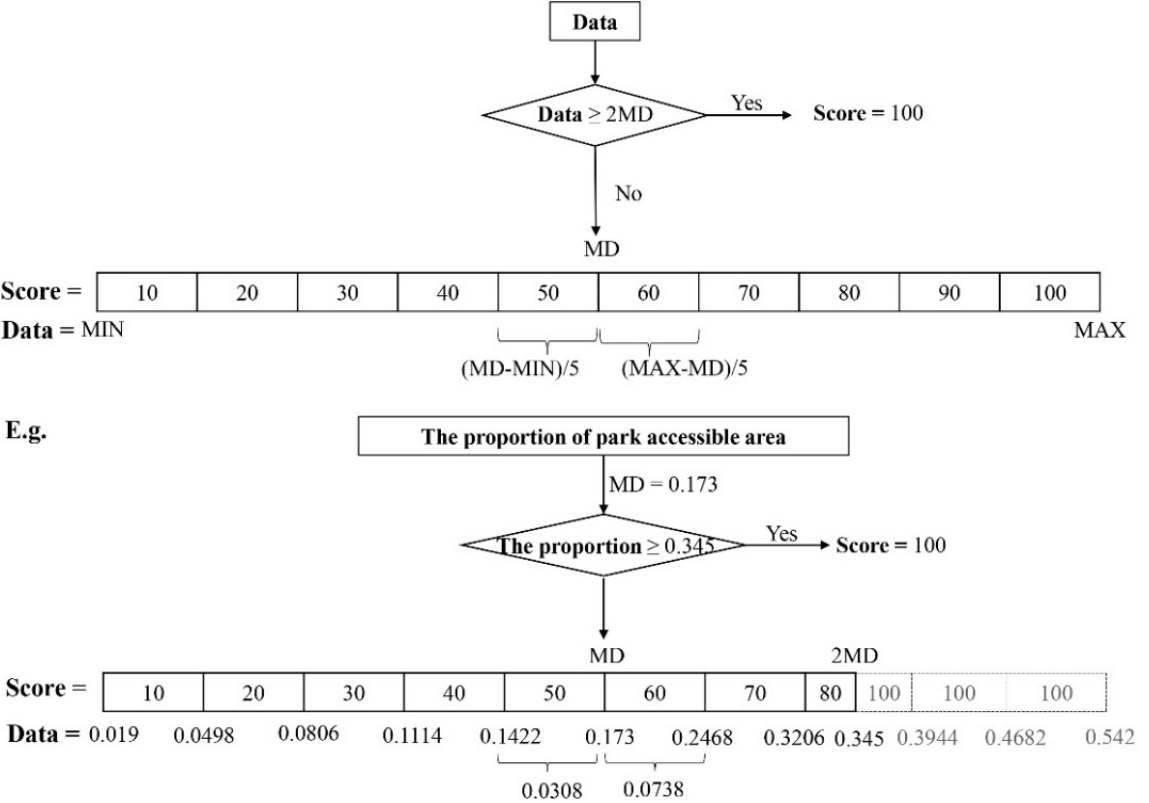
Figure 2. An example of the scoring process based on the proportion of park accessible area.